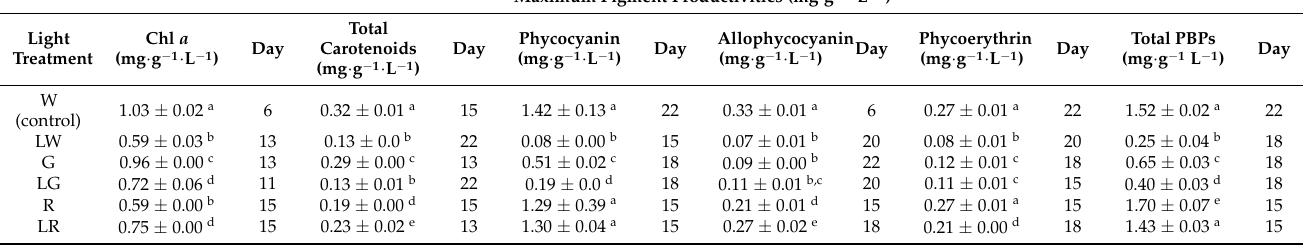
Table 4. Maximum productivities of pigments for light treatments applied to S. salina LEGE 06155: White (150 µ mol photons · m − 2 · s − 1 ) (control), low white (50 µ mol photons · m − 2 · s − 1 ), green (150 µ mol photons · m − 2 · s − 1 ), low green (50 µ mol photons · m − 2 · s − 1 ), red (150 µ mol photons · m − 2 · s − 1 ), and low red (50 µ mol photons · m − 2 · s − 1 ) applied. The lowercase letters denote statistically significant differences ( p < 0.05) for each parameter analyzed (in column). Results are reported as average ± SD (n = 3) and expressed in mg · g − 1 · L − 1